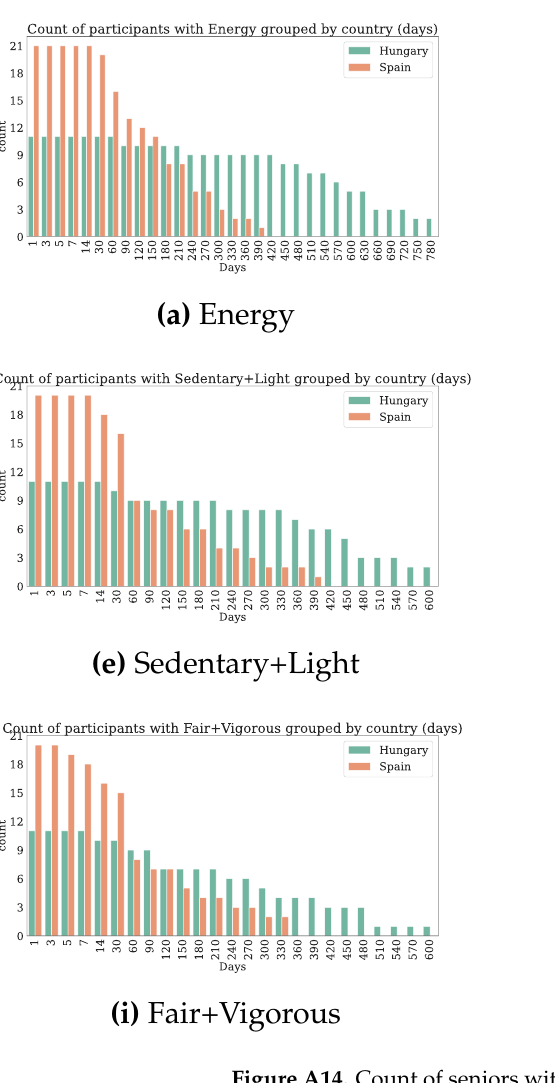
Figure A14. Count of seniors with at least the given valid days of Fitbit (TechRO) by outcome and country group